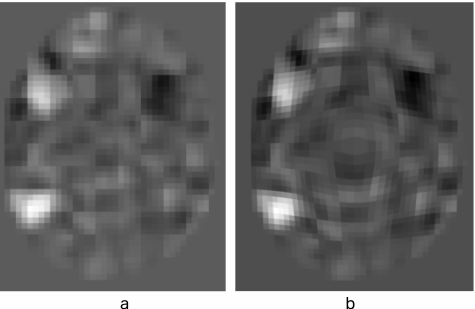
Figure 4. LANG Network ( a ) with Pinch-Explode augmentation ( b ).